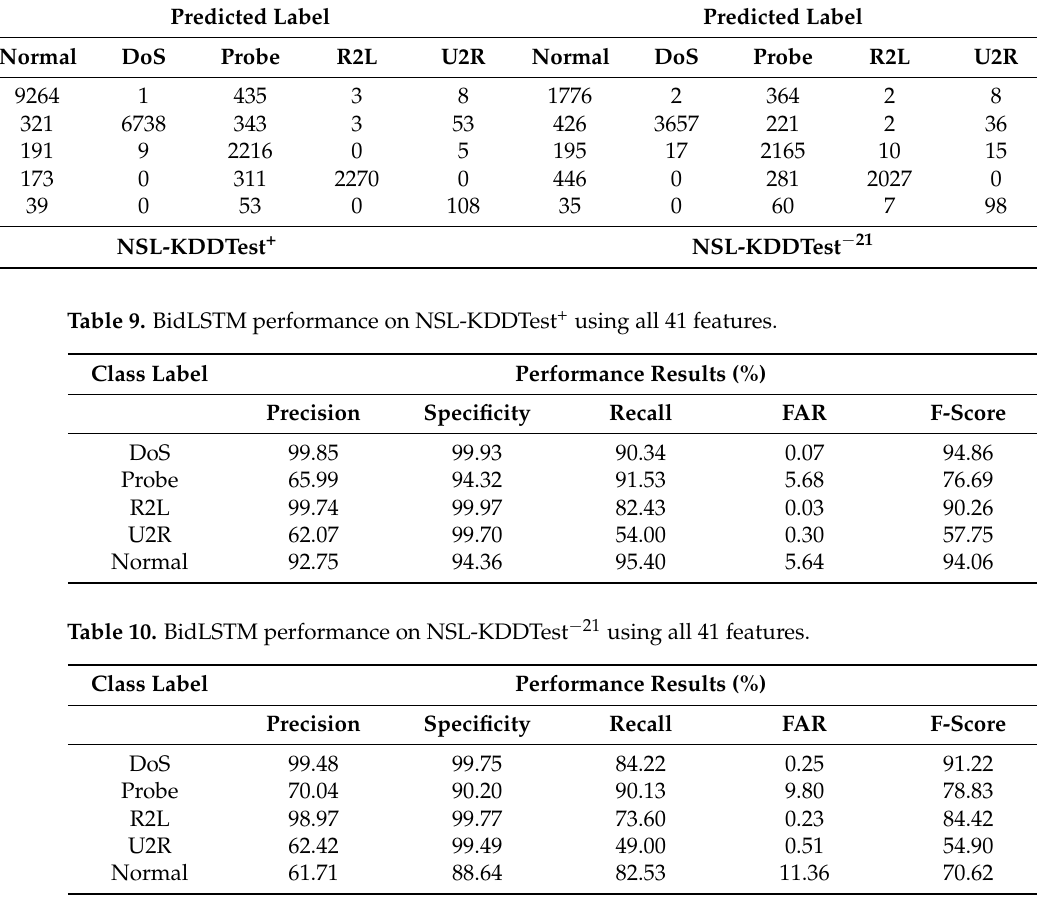
Table 8. Confusion matrix of BidLSTM model trained with all 41 features. Predicted Label